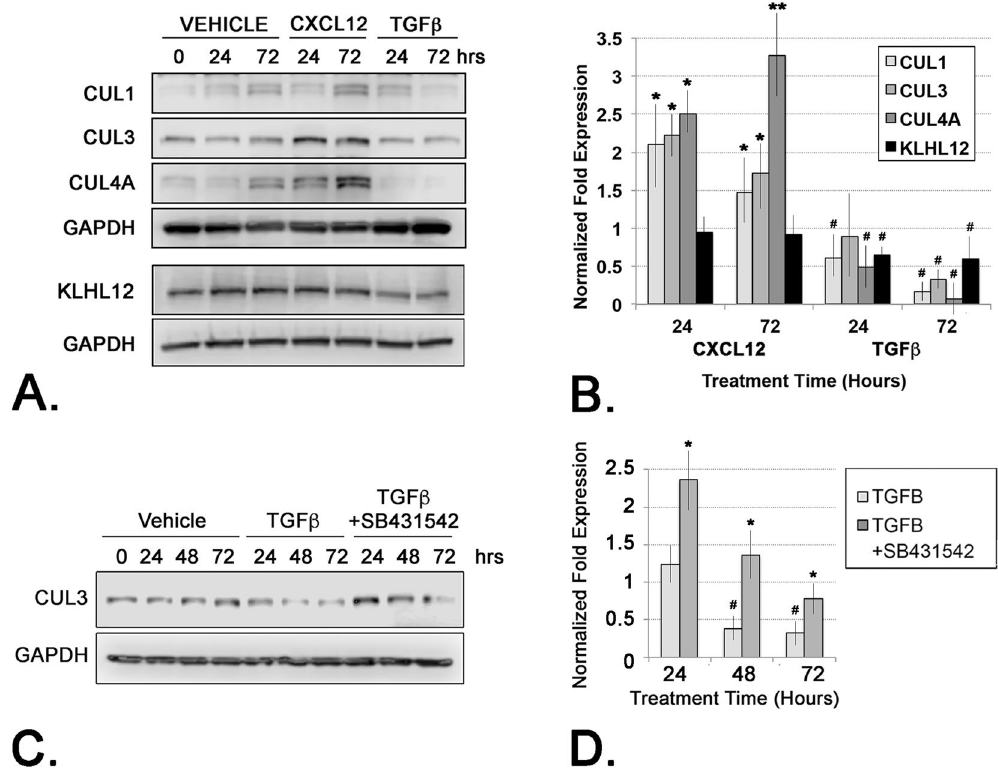
Figure 5. CXCL12 Up-Regulates RING-finger Type 3 Cullin-RBX E3 Ubiquitin Ligase and COPII Vesicle Proteins. ( A ) Immunoblot of protein lysates from cells treated with vehicle, CXCL12 or TGF β and probed for CUL1, CUL3, CUL4A, KLHL12 and GAPDH (as loading control) proteins. One filter was stripped and re-probed sequentially for the CUL and GAPDH proteins examined; a separate filter was stripped and re- probed for KLHL12 and GAPDH. ( B ) Graph of densitometric analysis of replicate immunoblots of ( A ) CXCL12 significantly up-regulated CUL1, CUL3 and CUL4A proteins at 24 and 72 hrs treatment compared to vehicle ( ** p < 0.001; * p < 0.05) whereas these same proteins were down-regulated below basal levels by TGF β compared to vehicle ( # p < 0.05). KLHL12 protein was significantly down-regulated ( # p < 0.05) in TGF β - treated, but not CXCL12-treated, cells. ( C ) Immunoblot of protein lysates from cells treated with vehicle, TGF β or the small molecule TGF β R1 inhibitor SB431542 + TGF β , and probed for CUL3 or GAPDH (as loading control) proteins. ( D ) Graph of densitometric analysis of replicate immunoblots as shown in ( C ) CUL3 protein expression is significantly repressed in TGF β -treated cells; this repression is lifted upon co-treatment with SB431542 ( # or * p < 0.05 compared to vehicle-treated cells). Graphs represent averaged measures of triplicate